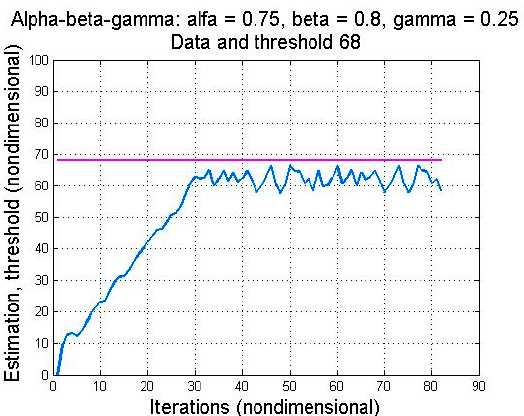
Figure 14. The α – β – γ filter is unable to provide an estimate that exceeds the threshold of 68. The same threshold value was used for the α – β – γ – δ filter. The results can be seen in Figure 15. The algorithm provides several estimations that exceed this threshold value. As such, the α – β – γ – δ filter is working for the threshold value of 68.